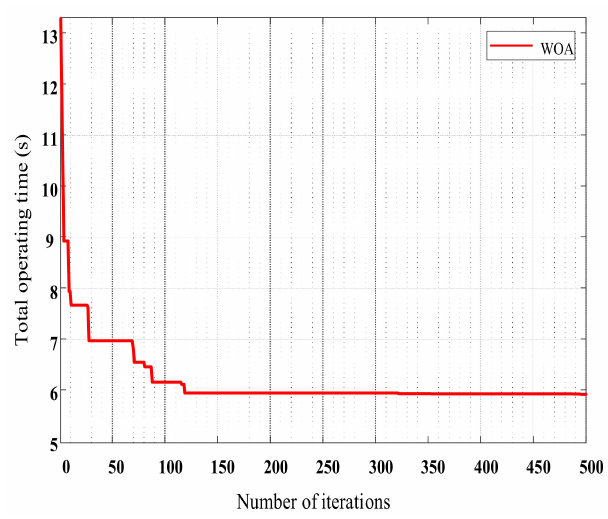
Figure 6. Convergence characteristic of WOA for case 2. Table 7. Comparison of the WOA result with the methods used in the literature for the IEEE eight-bus system.